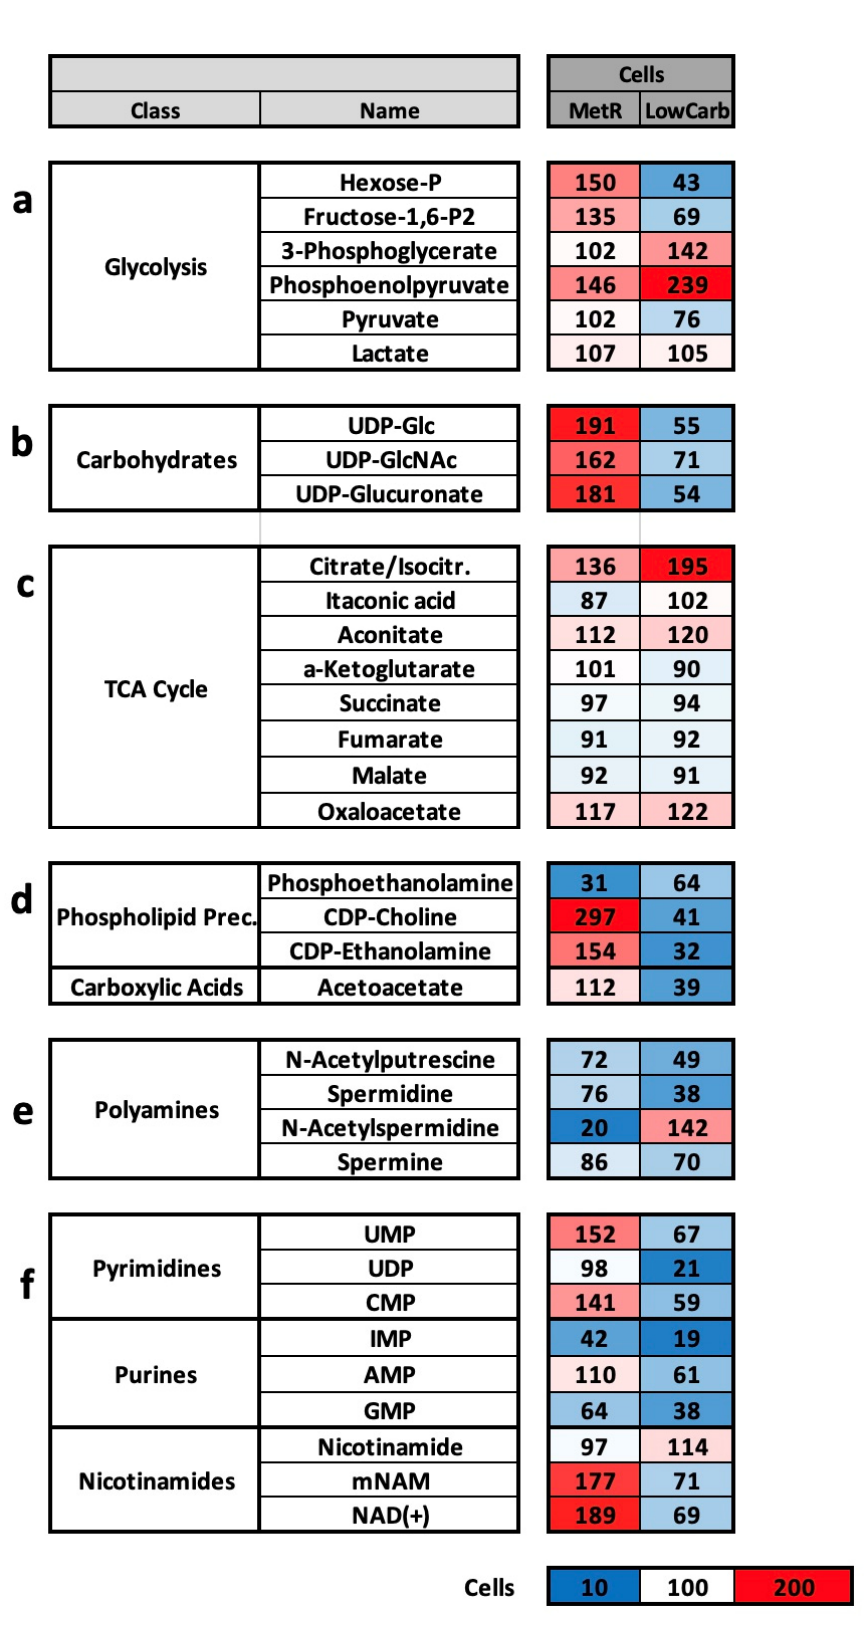
Figure 5. ( a – c ) Overview of metabolic classes and metabolic groups of liquid chromatography mass spectrometry of L929 cells in perfusion culture under MetR and LowCarb conditions. The metabolism of the murine cell line L929 was analysed via LC-MS in complete medium (control), MetR (0 mg/L), and Low Carb (3 mM glucose) for 7 days in a closed perfusion cell culture. After 7 days, the cell lysates (intracellular) and the medium (supernatant) were analysed by LC-MS. The